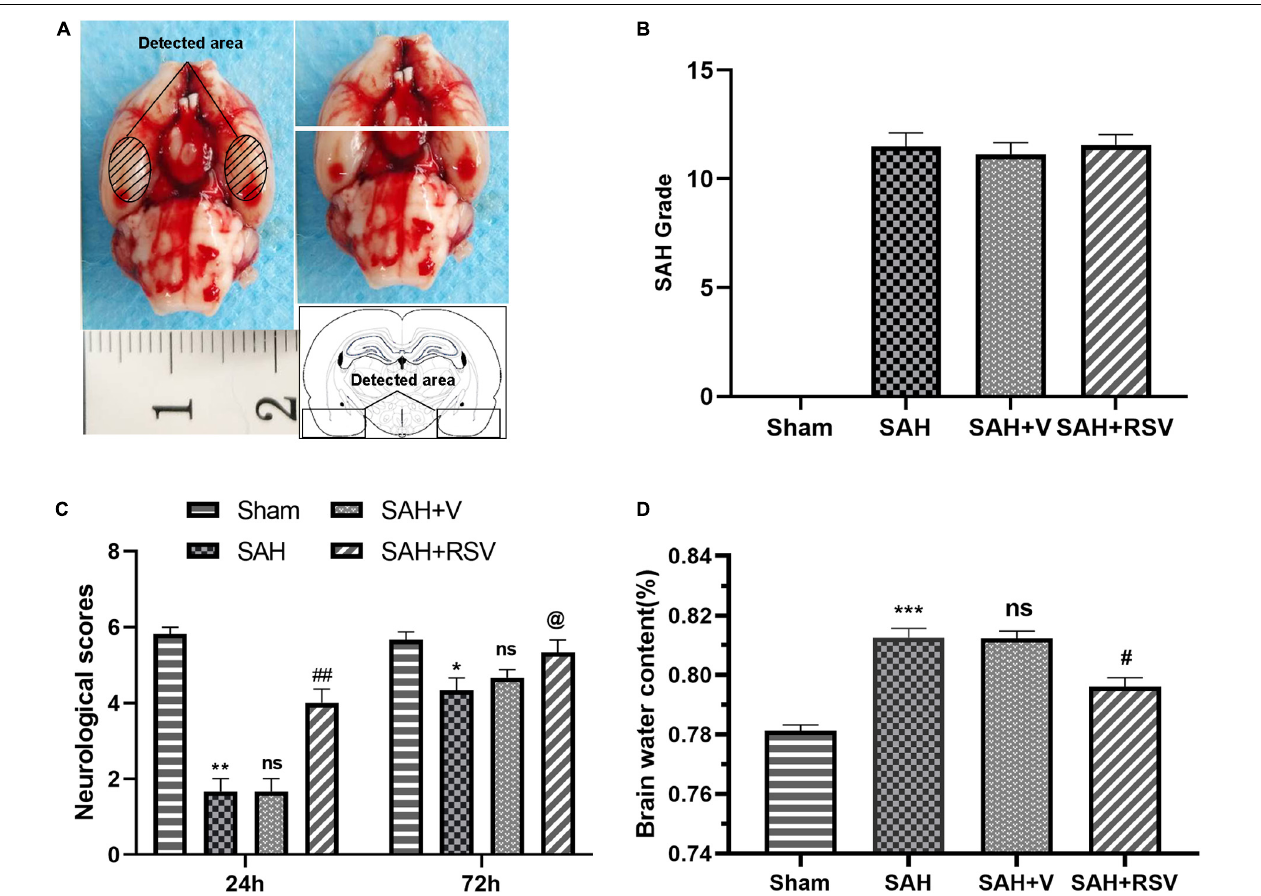
FIGURE 1 | Effects of RSV on subarachnoid hemorrhage (SAH) in rats. (A) Schematic representation of the inferior temporal cortex area sampled for analysis. (B) SAH grades. (C) Neurological function was assessed by neurological scores 24 and 72 h after SAH. (D) Brain water content in the RSV-treated group was obviously lower than that in the vehicle-treated group following SAH. Data were represented as mean ± SEM ( n = 6). * p < 0.05, ** p < 0.01, and *** p < 0.001 vs. sham group; ns p > 0.05 vs. group with SAH, @ p > 0.05, # p < 0.05, and ## p < 0.01 vs. vehicle-treated